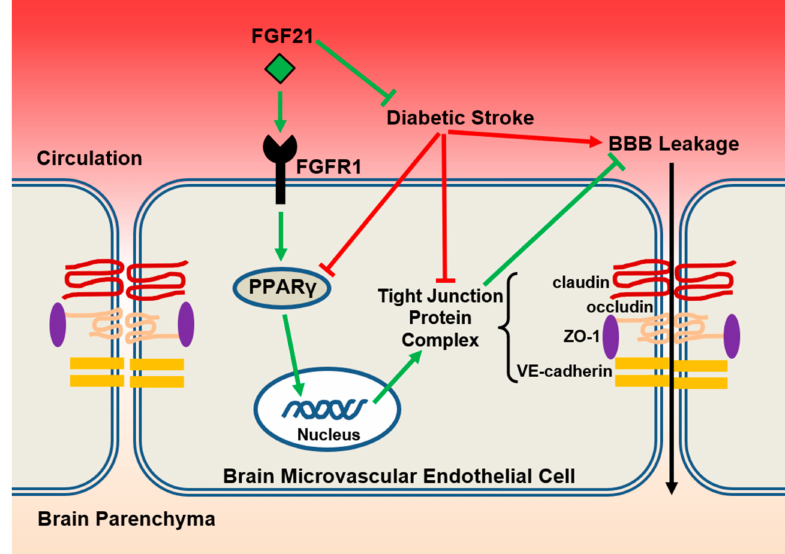
Figure 6. The proposed model. In the setting of diabetic ischemic stroke, brain microvascular endothelial cells su ff er more severe damage, including exacerbated reduction of PPAR γ activity and tight junction protein expressions, and subsequently augmented BBB leakage. Exogenous administration of rFGF21 exerts BBB-protective e ff ects through FGFR1-mediated elevation of PPAR γ activity and upregulation of tight junction protein expressions and eventually mitigates the poststroke BBB permeability in the context of type 2 diabetes mellitus